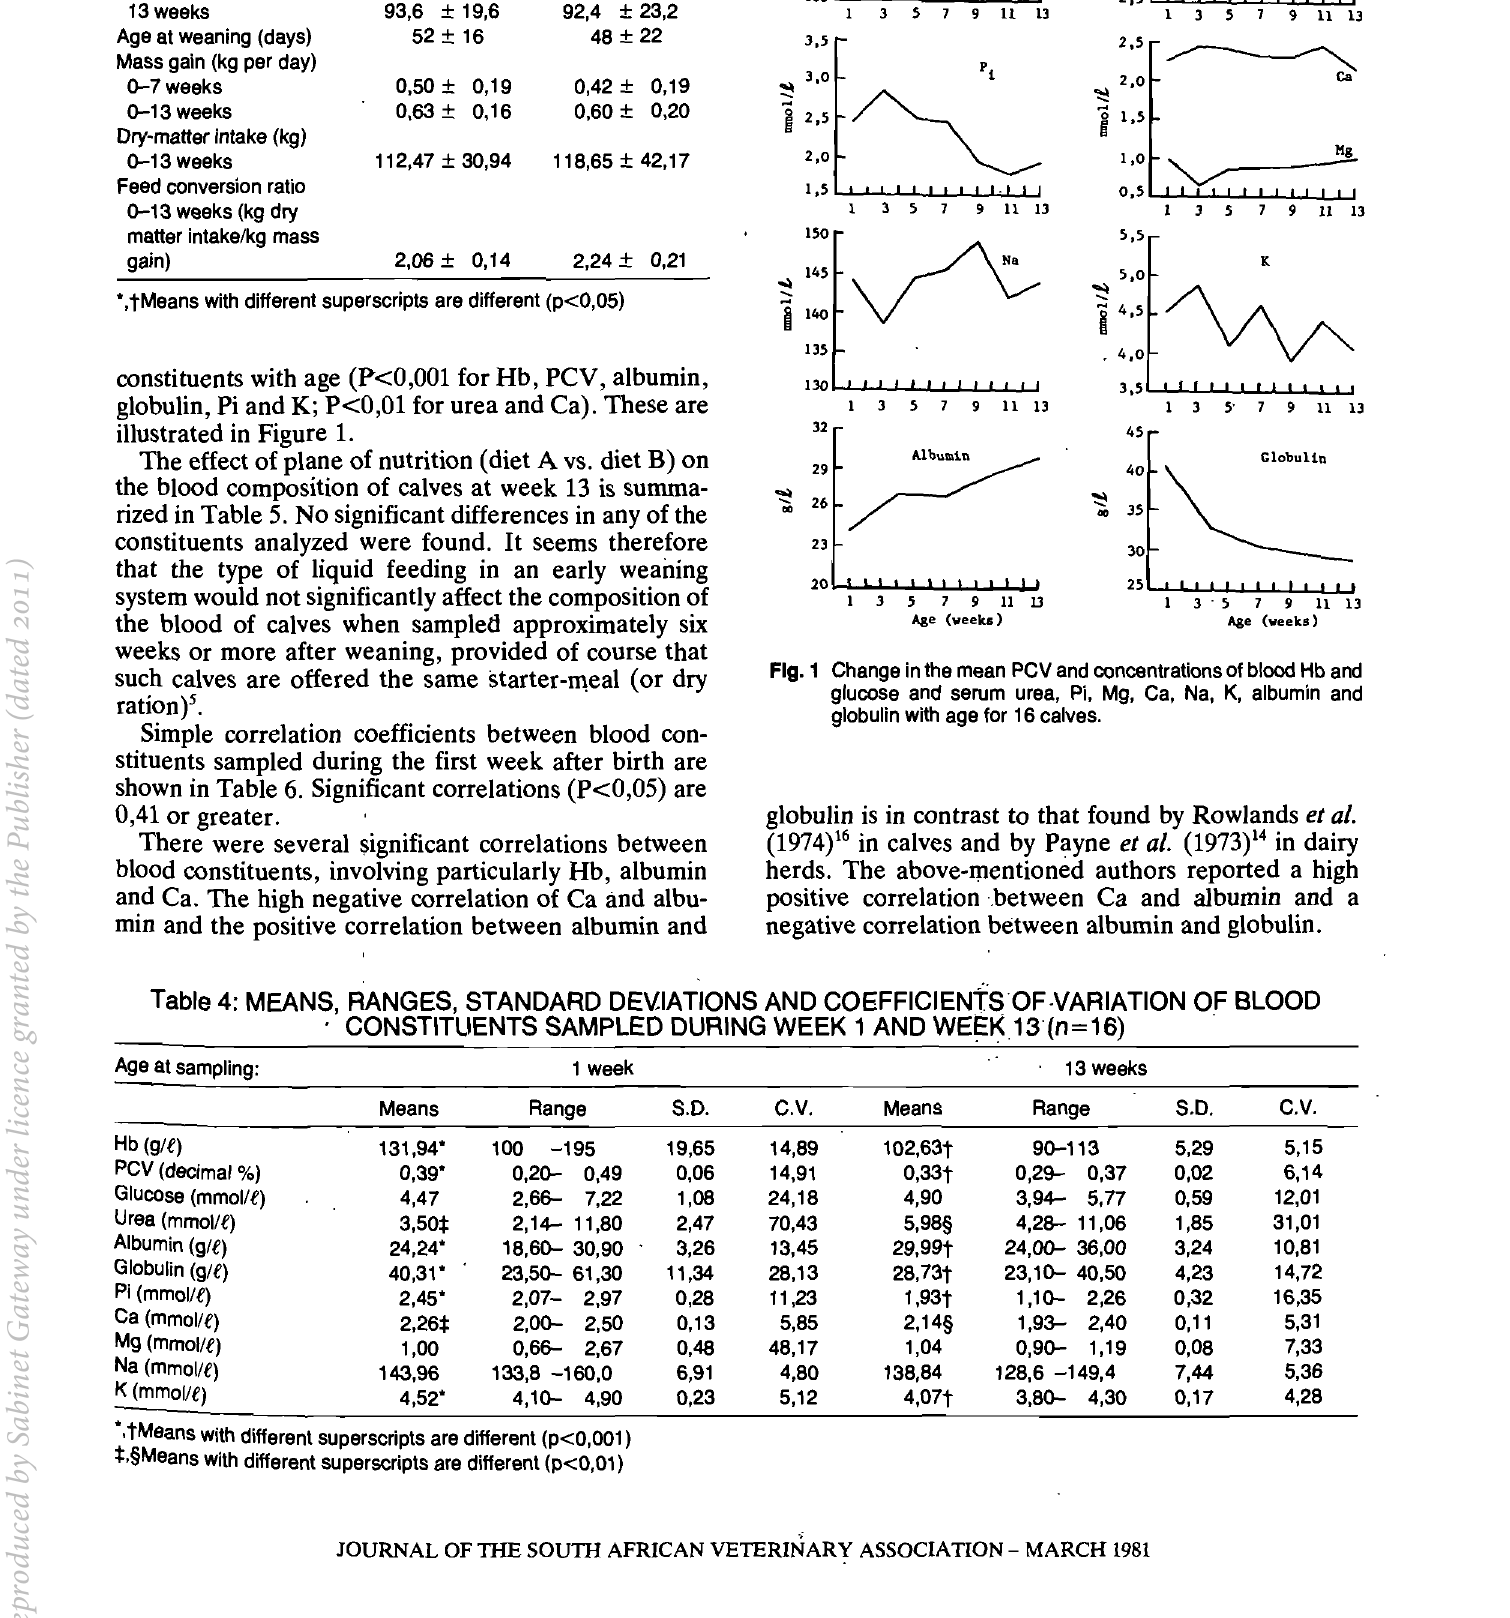
Table 3: MEANS AND STANDARD DEVIATIONS OF BODY MASSES, AGE AT WEANING, LIVE MASS GAIN, DRY-MATTER INTAKE AND FEED' CONVERSION RATIO FOR THE TWO GROUPS OF CALVES